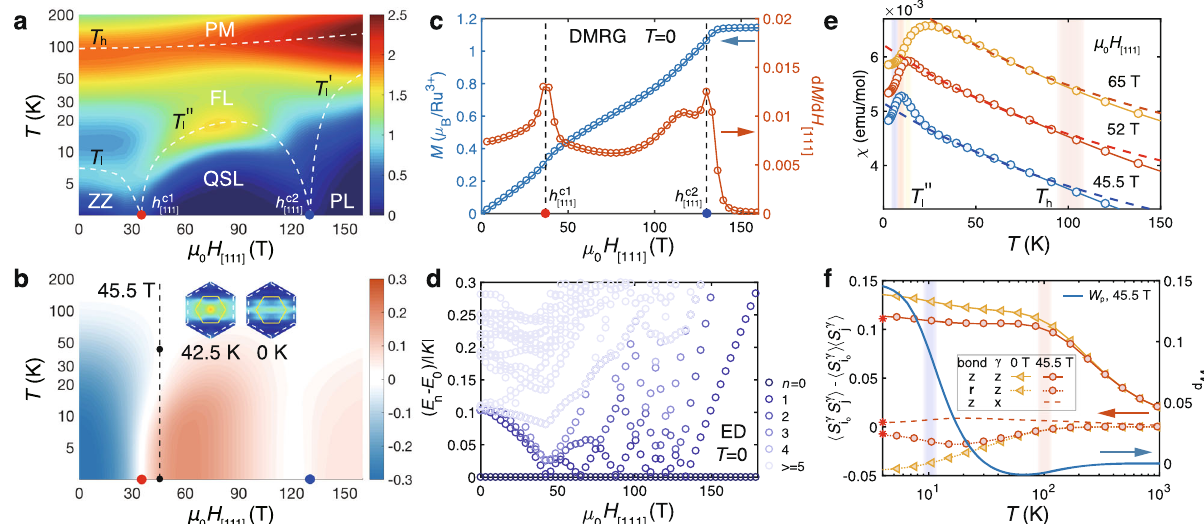
Fig. 5 Quantum spin liquid regime of α -RuCl 3 model under the out-of-plane fi eld H [111] ∥ c * . a Color map of the speci fi c heat C m , where a double-peak feature appears at both low and intermediate fi elds. The white dashed lines, with T h , T l , and T 00 determined from the speci fi c heat and T 0 from spin structure l l (cf. Supplementary Note 4), represent the phase boundaries and are guides for the eye. b shows the Z 2 fl ux W p , where the regime with positive(negative) W fi nite-temperature spin structure factors ~ S zz ð k Þ (see main text) at μ H = 45.5 T are shown in the inset of ( b ) p is plotted in orange(blue). The zero and 0 [111] and plotted with the same colorbar as that in Fig. 3e-g. c Shows the T = 0 magnetization curve and its derivative d M /d H [111] , where the two peaks can be clearly identi fi ed at μ 0 H [111] ≃ 35 and 130 T, respectively. The two transition fi elds, marked by h c 1 and h c 2 , are also indicated in panels a and b . d ED ½ 111 (cid:3) ½ 111 (cid:3) Energy spectra E n - E 0 under H [111] fi elds, with gapless low-energy excitations emphasized by dark colored symbols. e The magnetic susceptibility with an intermediate- T Curie-Weiss behavior, with the fi tted C 0 ’ 1.22, 1.14, and 1.00 cm 3 K/mol and θ 0 ’ -236.8, -217.8, and -187.4 K, for fi elds μ 0 H [111] = 45.5, 52 and 65 T, respectively. The susceptibility curves in e are shifted vertically by a constant 0.001 emu/mol for clarify. f shows the temperature dependence of S z S z S z z - and r -bonds [see Fig. 1a], the spin correlations (left y -axis) and the fl ux W p (right y -axis), where the correlations h S z i j i - h i 0 ih j i are measured on both 0 S x S x S x z -bond, under two different fi elds of 0 and 45.5 T (with i fi xed central reference site). The low- T XTRG data are shown and h S x i j i - h i 0 ih j i on the 0 a 0 to converge to the T = 0 DMRG results, with the latter marked as red asterisks on the left vertical axis. The fl ux expectation W p are measured under μ H = 45.5 T, which increases rapidly around low- T scale T 00 0 [111] l